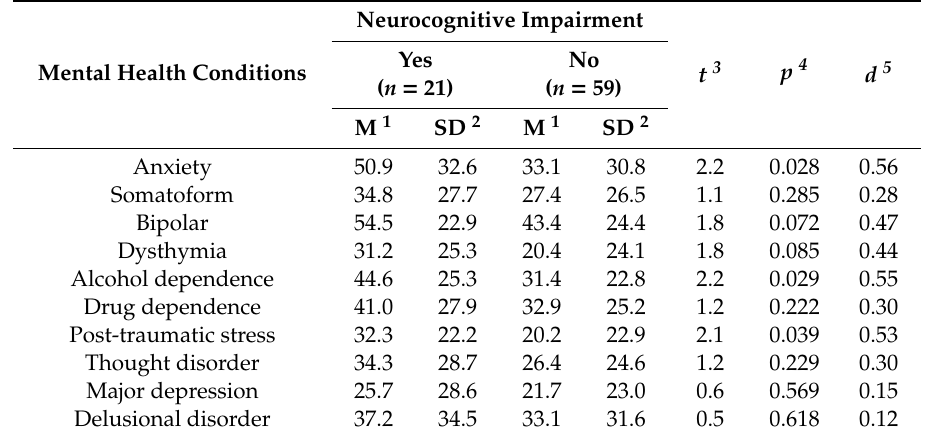
Table 4. Results of comparing the means for NCI or not samples in mental health conditions ( N = 80).